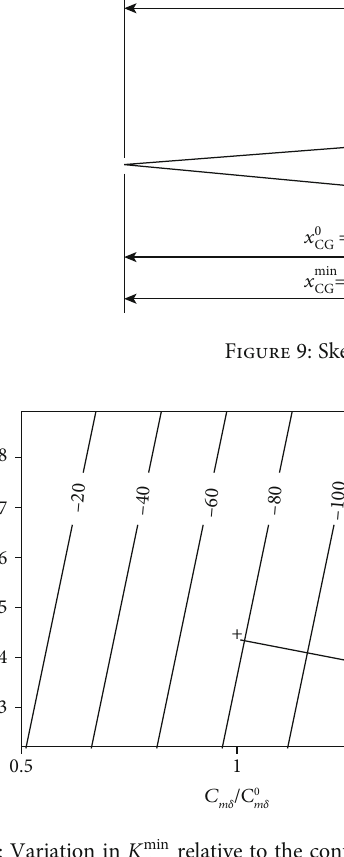
relative to the control derivatives. +: n